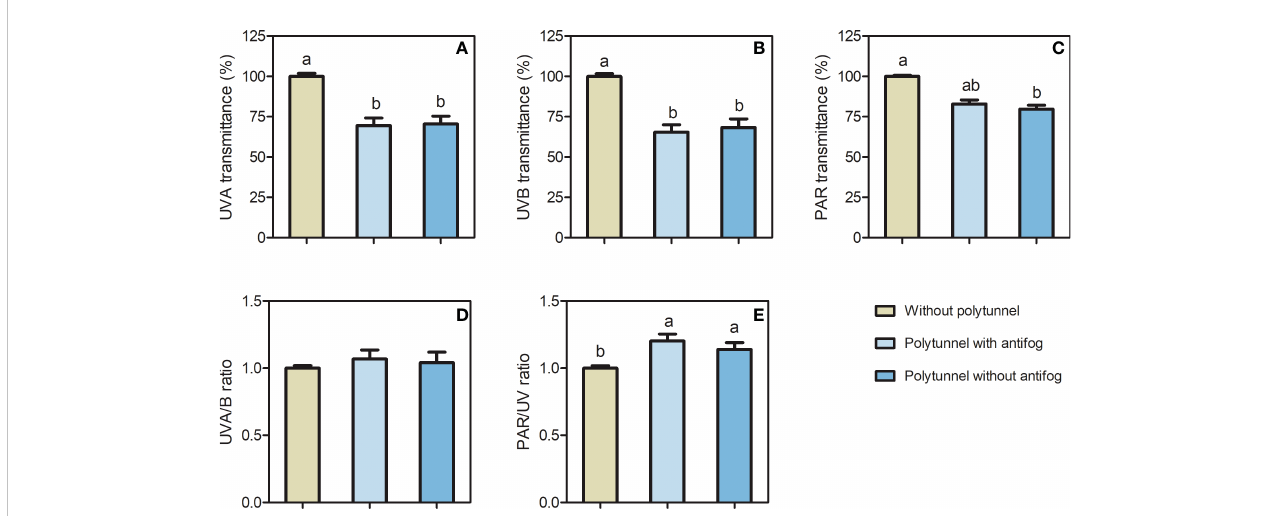
FIGURE 2 Differences in light intensity and light quality without and under polytunnels. (A, B) UV, and (C) PAR transmittance (%) of polytunnel materials with and without antifogging additives compared to without polytunnels, (D) UVA/B ratio, and (E) UV/PAR ratio. Measurements were conducted within the second experimental repetition (in May). Data represent mean ± SD (n = 4). Different letters indicate signi fi cant differences (p ≤ 0.05); no letters indicate no signi fi cance. UV, ultraviolet; PAR, photosynthetic active